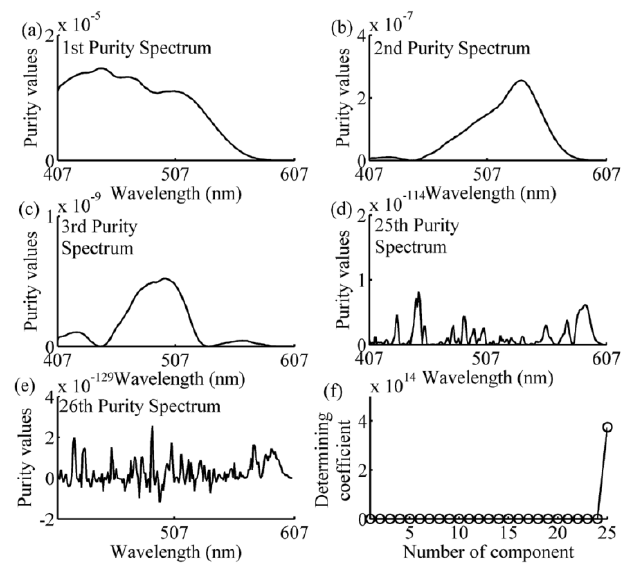
Figure 6. Purity spectra and determining coefficient during the processing of four-component sample’s calibration subset spectra. ( a ) 1st purity spectrum; ( b ) 2nd purity spectrum; ( c ) 3rd purity spectrum; ( d ) 25th purity spectrum; ( e ) 26th purity spectrum; ( f ) determining coefficient. The components are amaranth (50 μg/mL), carmine (60 μg/mL), tartrazine (40 μg/mL), and sunset yellow FCF (30 μg/mL).